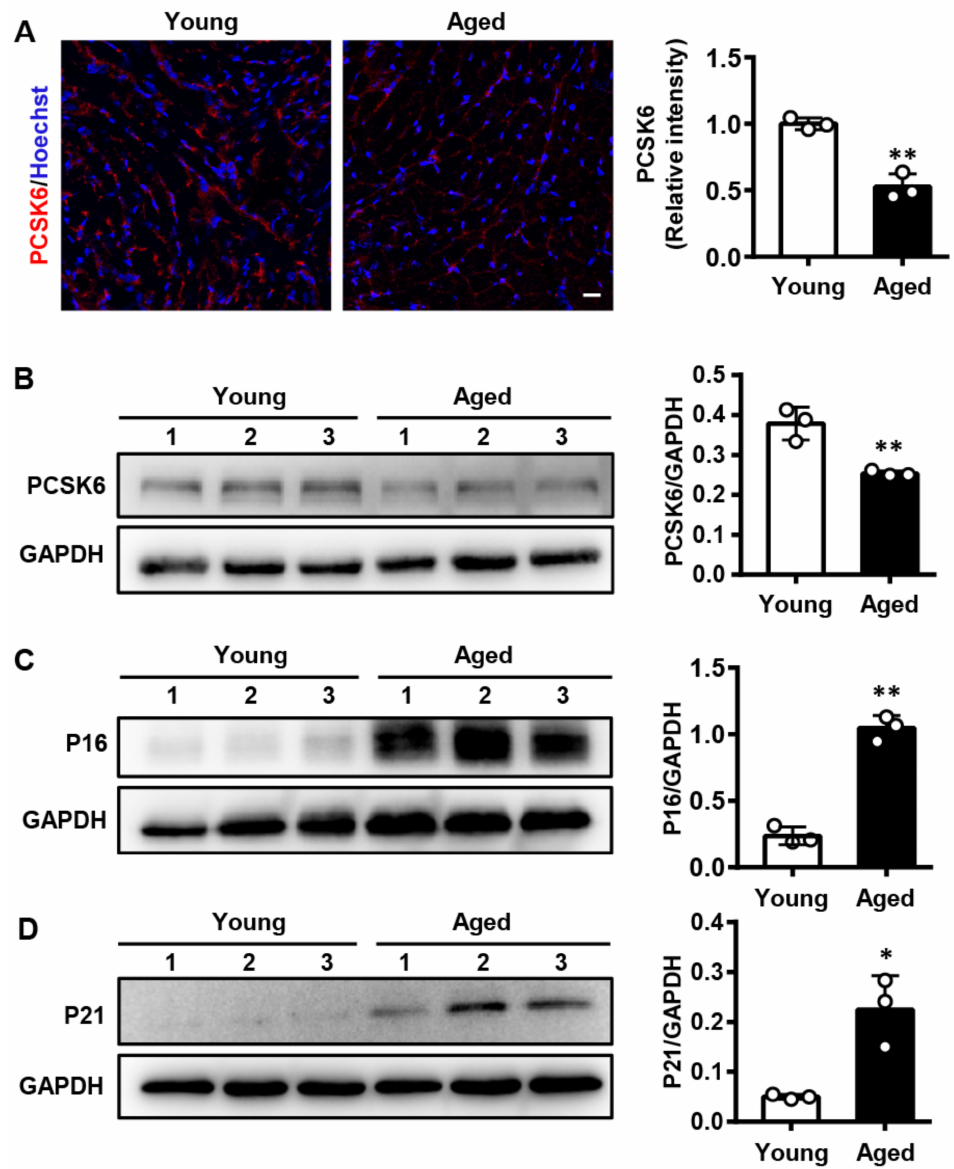
Figure 1. Decreased PCSK6 protein expression in aged mouse hearts. ( A ) Immunofluorescent staining for PCSK6 (red) and nuclei (blue) in frozen heart sections from young mice (3 months, n = 3) and aged mice (24 months, n = 3). Scale bar: 20 µ m. Relative levels were calculated according to mean fluorescent intensity. ( B – D ) Western blot analysis of PCSK6, P16, and P21 protein levels in hearts from young mice (3 months, n = 3) and aged mice (24 months, n = 3). Relative expression, normalized to GAPDH level, was assessed by densitometry. Values are mean ± S.D. * p < 0.05, ** p < 0.01 vs.